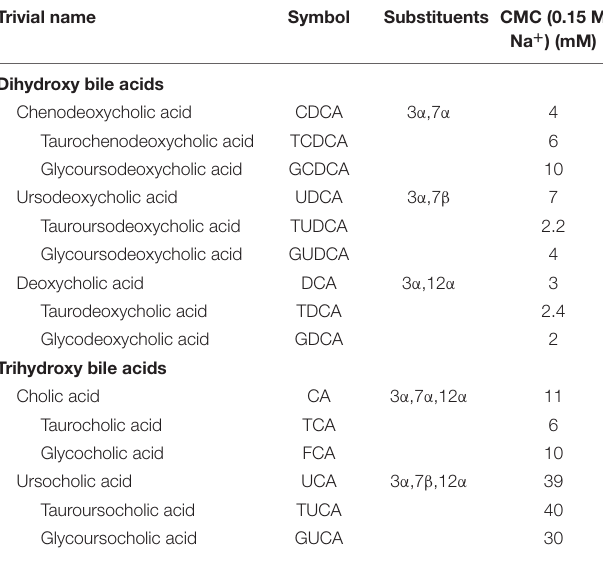
TABLE 2 | Critical micellar concentrations (CMCs) of selected bile acids and their conjugates (reported by Roda et al.,